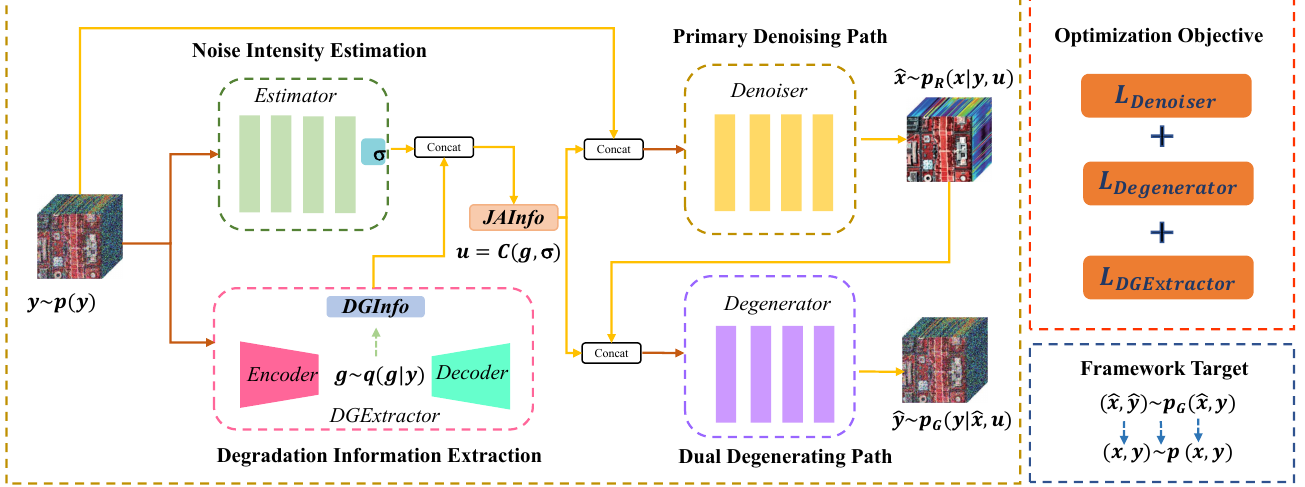
Figure 2. Overview of our DIBD